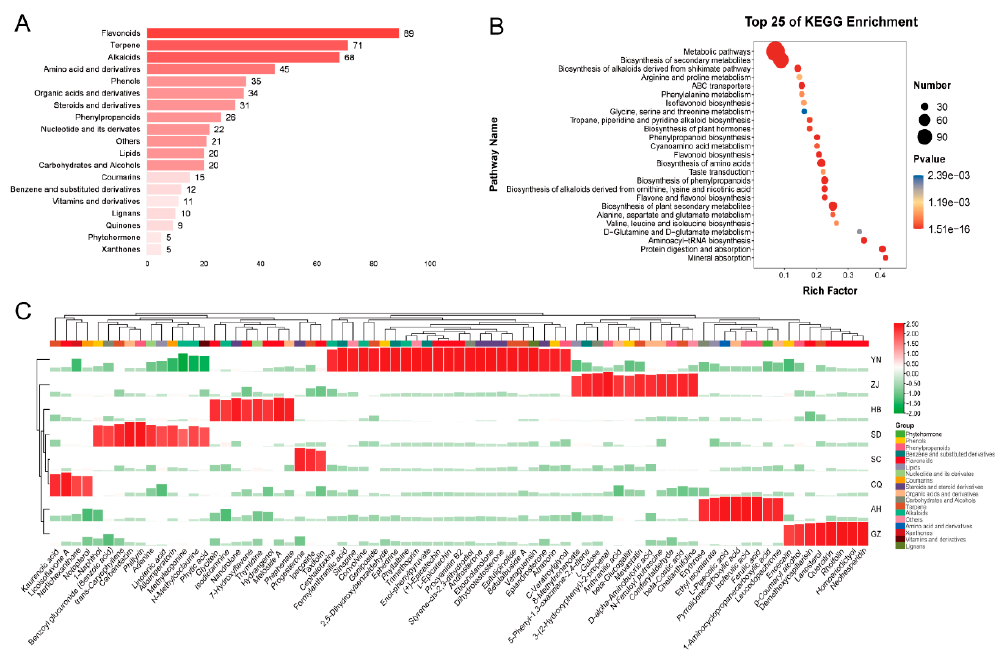
Figure 4. Analysis of 548 differential metabolites. ( A ) Classification of 548 differential metabolites of C. speciosa ( B ) KEGG enrichment analysis of 548 differential metabolites and the top 25 pathways. ( C ) Potential marker metabolites selected to visualize the marker metabolites of each region.